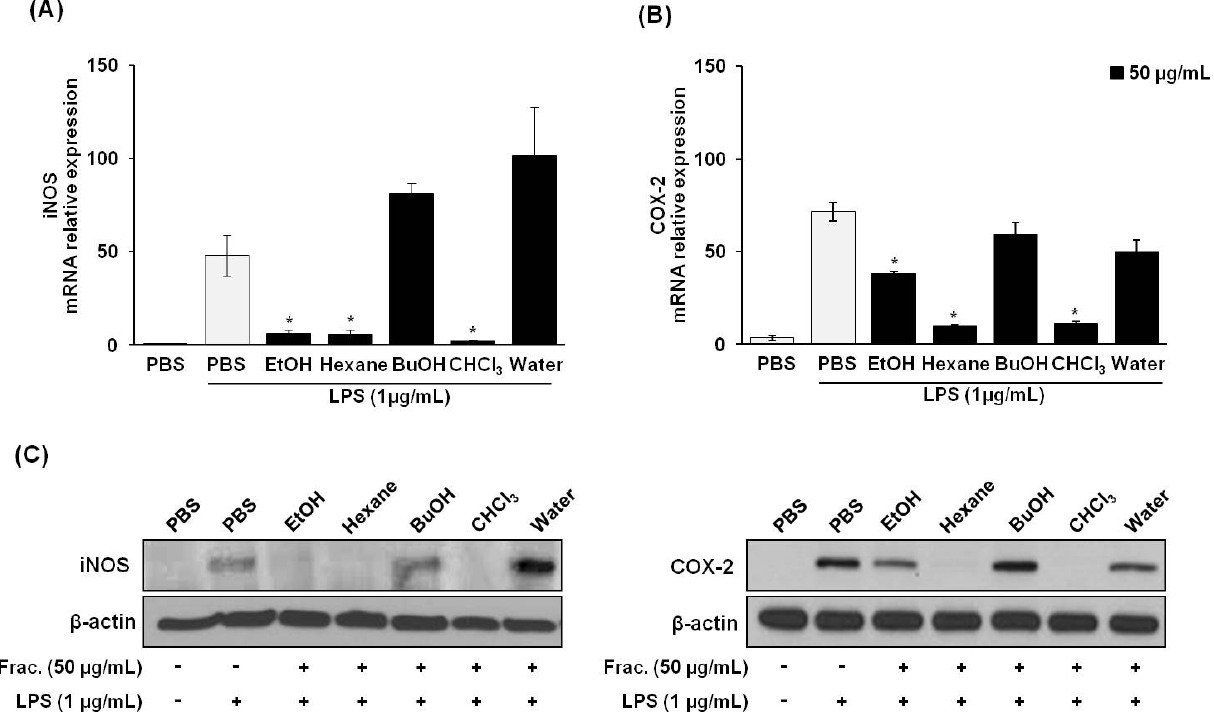
Figure 3. Effects of solvent fractions from Prunella vulgaris var. lilacina on LPS-induced pro-inflammatory mRNA expression and protein levels in RAW 264.7 cells. Cells were treated with fractions (50 μ g/mL) and stimulated with LPS (1 μ g/mL) for 12 h. ( A , B ) After incubation, cells were harvested for real-time RT-PCR to determine mRNA expression for ( A ) iNOS and ( B ) COX-2. ( C ) After incubation, cell lysates were used to determine iNOS and COX-2 protein levels via Western blot. Values show the means and standard deviations of three different experiments performed in triplicate. * p < 0.05 significantly different from the LPS-treated PBS